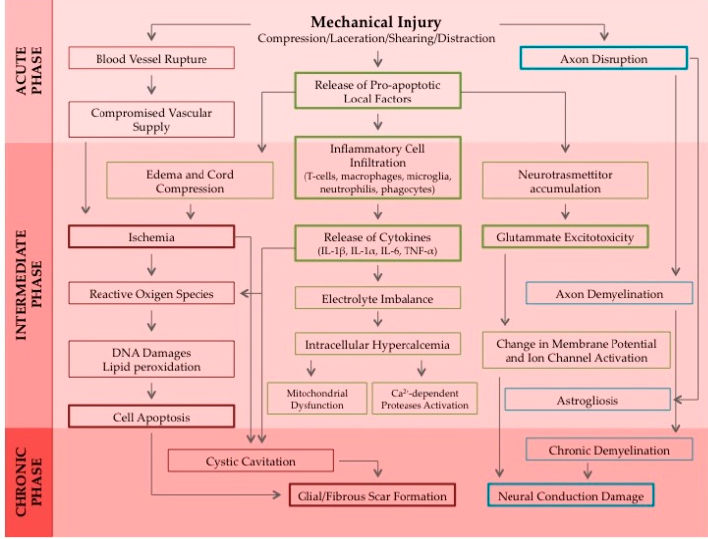
Figure 1. This is a schematic representation of the cascade of events that are included in the pathophysiological response to a spinal cord injury induced by a mechanical trauma. All the phases from the acute to the sub-acute and chronic SCI are being depicted until cavitation occurs in the lesion site and the glial scar forms. Abbreviations used: IL-1 α : Interleukin 1 α ; IL-1 β : Interleukin 1 β ; IL-6: Interleukin 6; TNF- α : Tumor Necrosis Factor α . Figure reprinted with permission from “Nanofiber Scaffolds as Drug Delivery Systems to Bridge Spinal Cord Injury” by Faccendini et al., Pharmaceuticals 2017, 10, 63, licensed under a Creative Commons Attribution license [4].